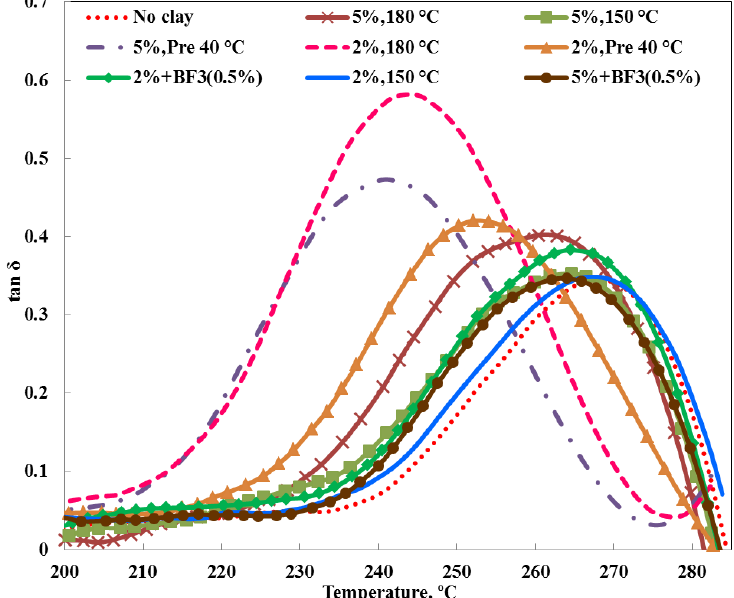
Figure 11. Tan δ as a function of temperature, at a frequency of 1 Hz, for different TGAP/clay nanocomposites, as